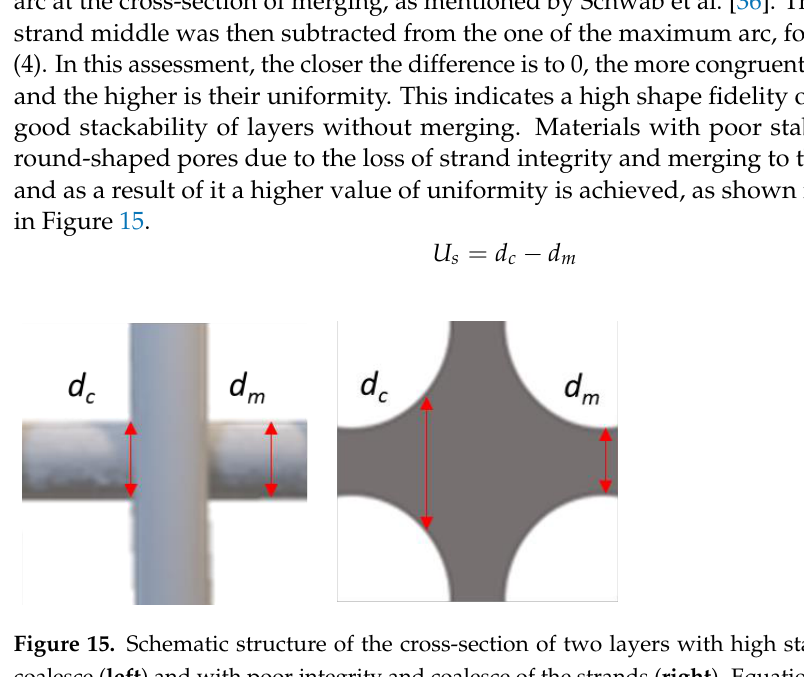
Figure 14. The influence of pore shape on the P r index in a grid structure. The schematic structure was designed based on Ouyang et al. [35].